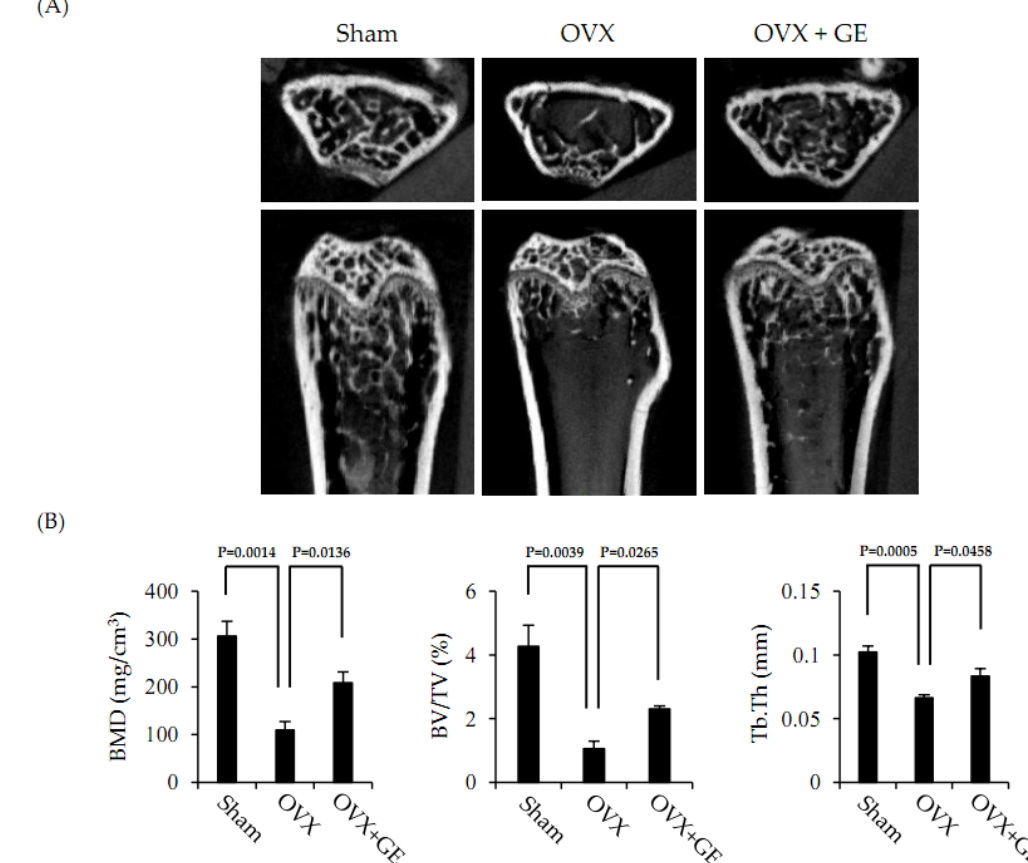
Figure 4. The preventive effect of GE on osteoporosis induced by OVX. ( A ) Representative micro ‐ CT transaxial and coronal images femurs from sham ‐ operated, untreated ‐ OVX, and GE (100 mg/kg) ‐ treated ‐ OVX mice. ( B ) Bone mineral density (BMD; mg/cm 3 ), bone volume/tissue volume (BV/TV; %), and trabecular thickness (Tb.Th; mm) were analyzed by using a Quantum GX micro ‐ CT imaging system (PerkinElmer). Results are presented as means ± SE ( n = 6).